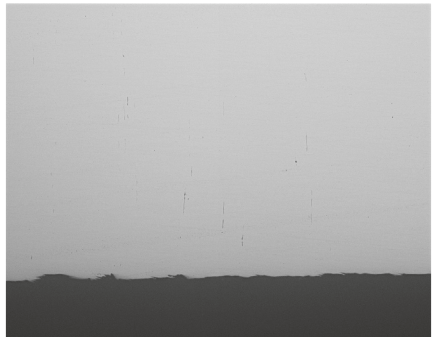
Figure 12: Micromorphology of nonmetallic.